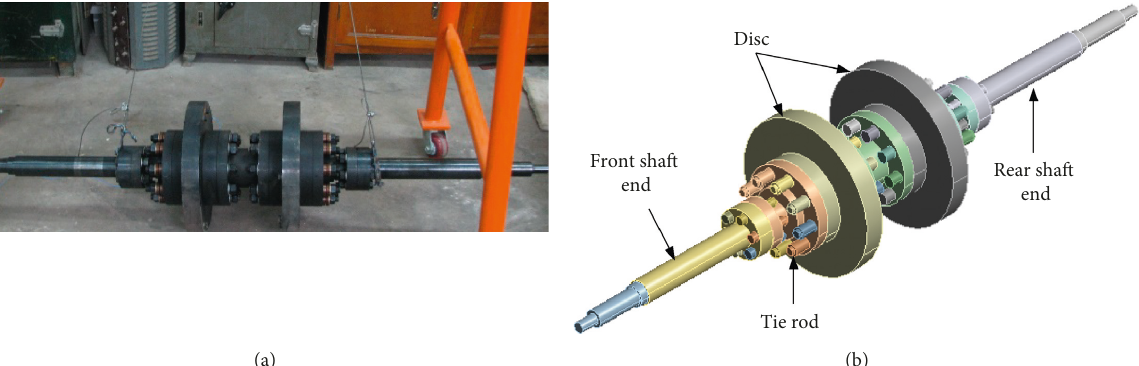
Figure 2: The structure of the experimental rod-fastened rotor. (a) The machining model of the experimental rod-fastened rotor. (b) The three-dimensional model of the experimental rod-fastened rotor.